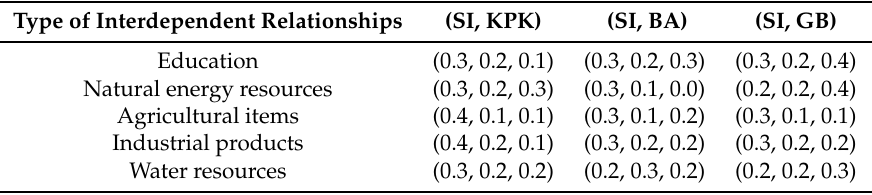
Table 3. IN set of interdependent relationships between Sindh and other provinces. Type of Interdependent Relationships